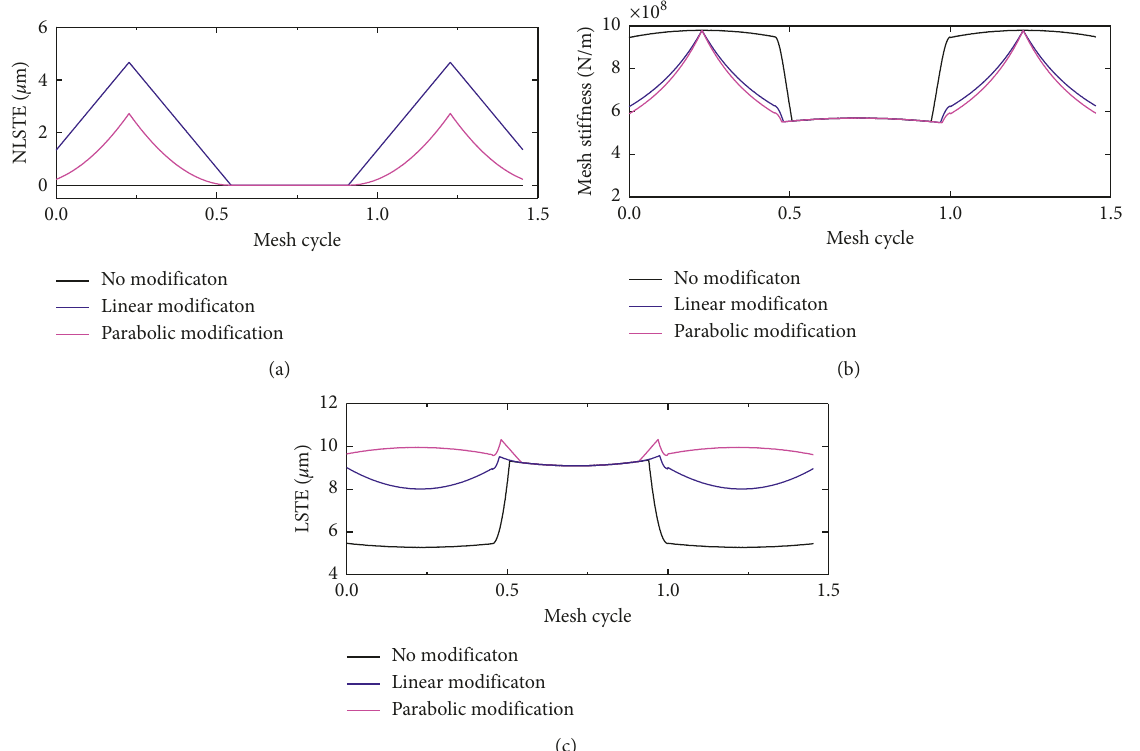
Figure 14: TVMS and TEs of a sun-planet mesh gear pair influence of the modification curve: (a) NLSTE; (b) TVMS; (c) LSTE.